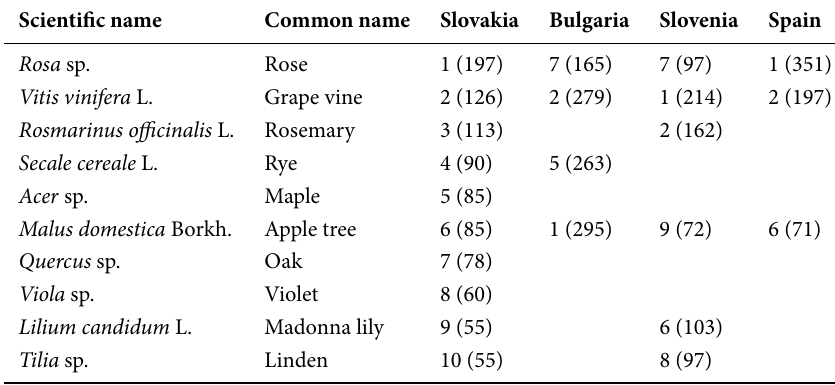
Table 1 Ten most mentioned species in Slovak folk songs and their representation in folk songs of other European